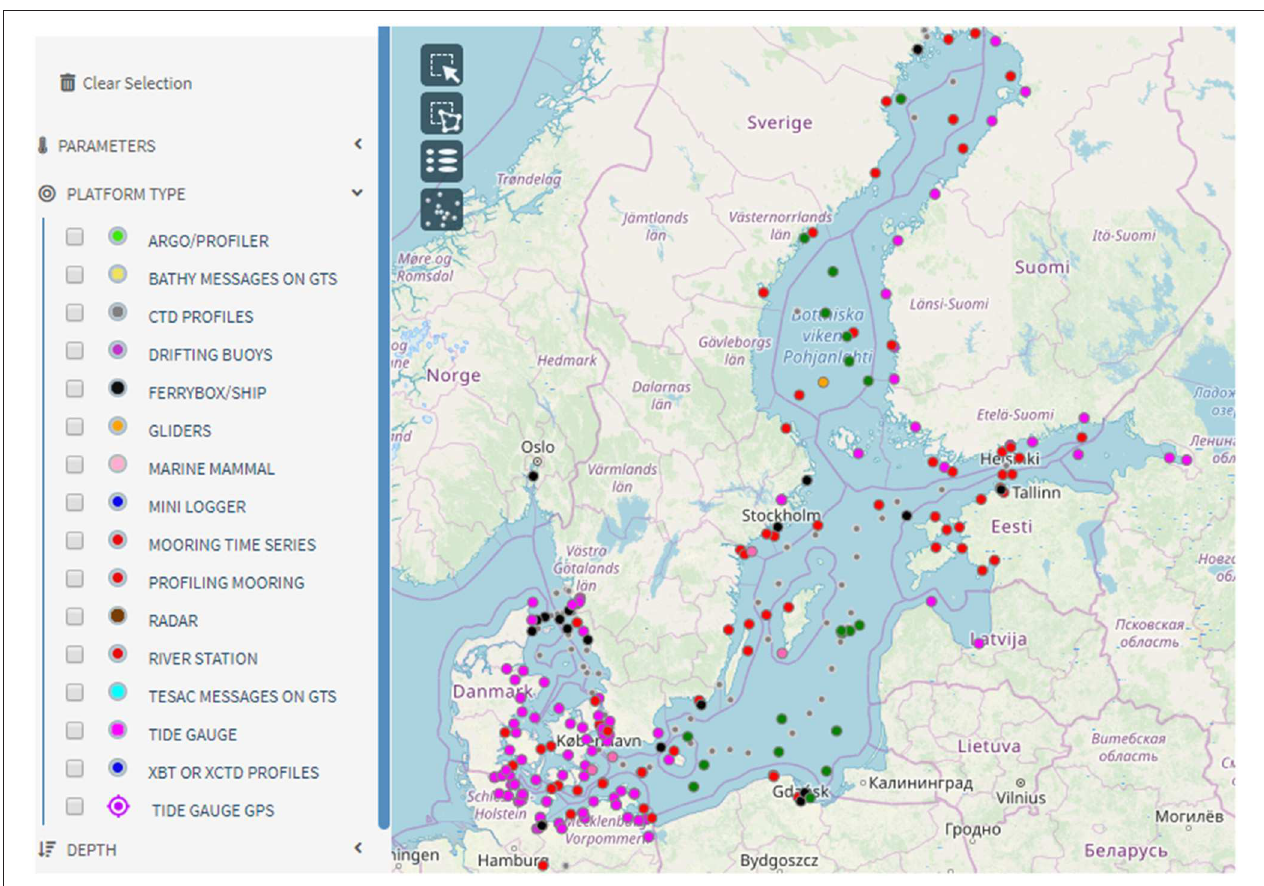
FIGURE 1 | Station distribution of operational observations in the Baltic